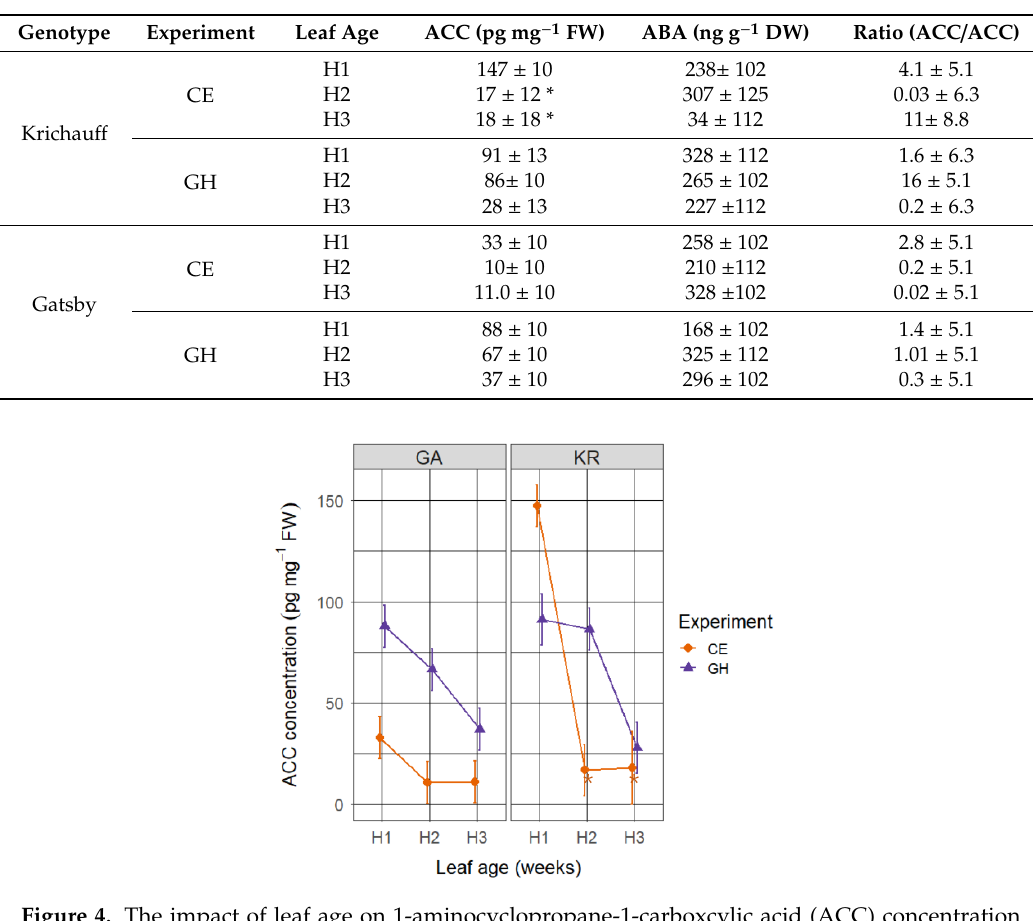
Figure 4. The impact of leaf age on 1-aminocyclopropane-1-carboxcylic acid (ACC) concentration in leaves of two wheat cultivars (KR, Krichauff; GA, Gatsby) grown in the glasshouse (GH) or controlled environment (CE) chamber. Orange asterisks indicate significant difference from H1 in the CE experiment. Samples were collected after gas exchange measure were complete from young expanding (H1-21 DAS), fully expanded (H2-28 DAS) and mature (H3-35 DAS) leaves. Data points represent the means ± standard errors of 3 biological replicates.